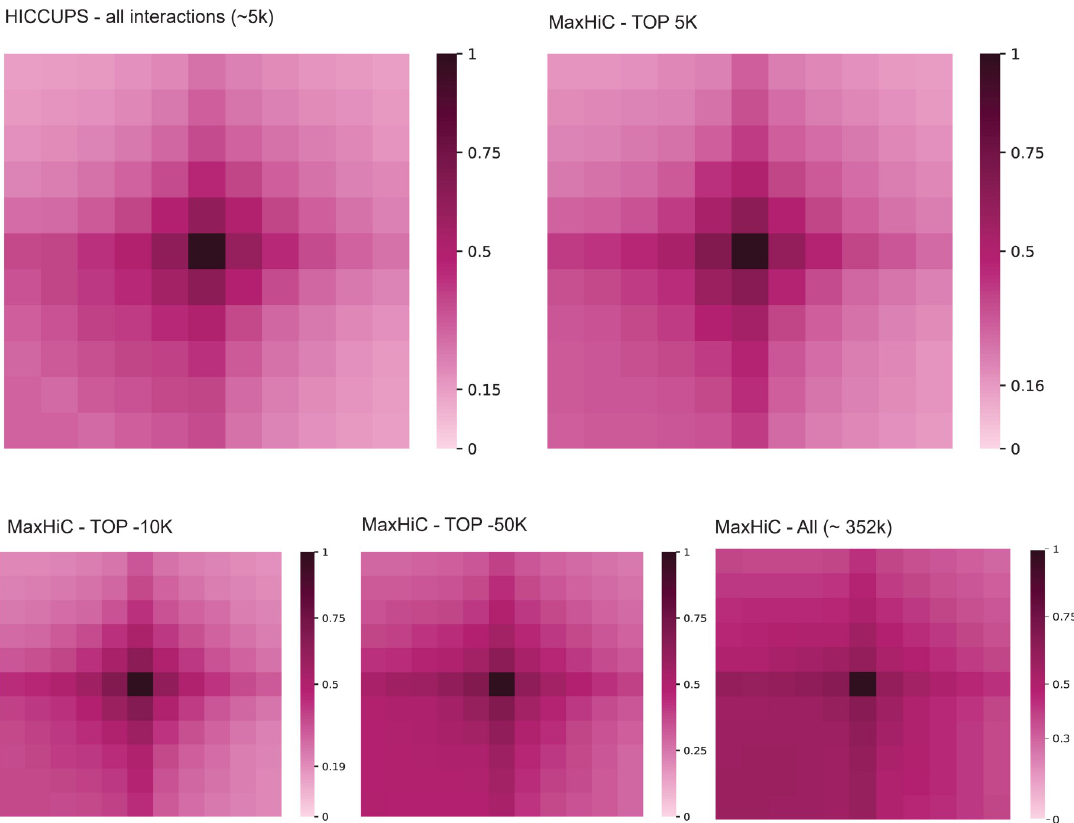
Fig 5. Aggregate peak analysis (APA) of significant interactions called by MaxHiC and HiCCUPS. Interactions were called at 10kb resolution using the GM12878 Hi-C dataset from Rao et al . The analysis shows the aggregate background interaction frequency of 5 bins upstream and downstream of the significantly interacting bins. For HiCCUPS the bins at the centroid of the loop regions are used. For HiCCUPS the APA for all 5,348 interactions is shown. For MaxHiC, APA plots are shown for the top 5k, 10k, 50k and all 243k significant